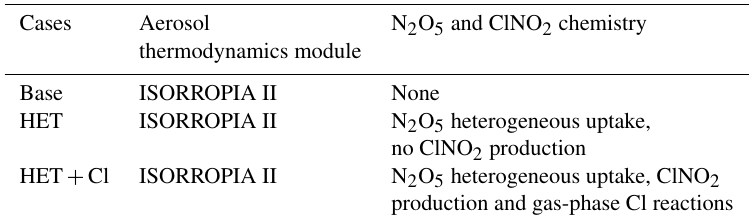
Table 2. Simulation